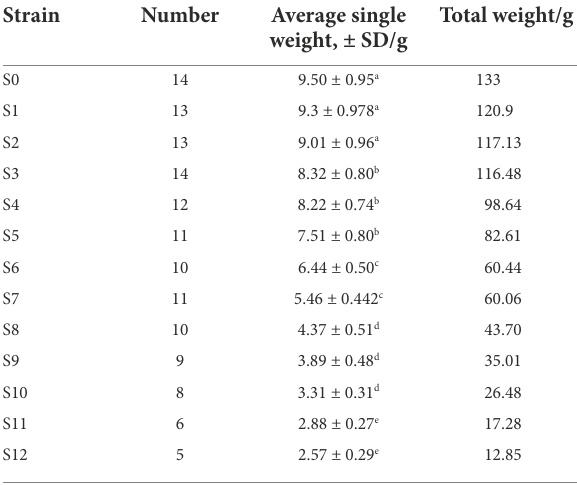
TABLE 1 Number, average single weight and total weight of fruiting bodies of subcultured V. volvacea strains.